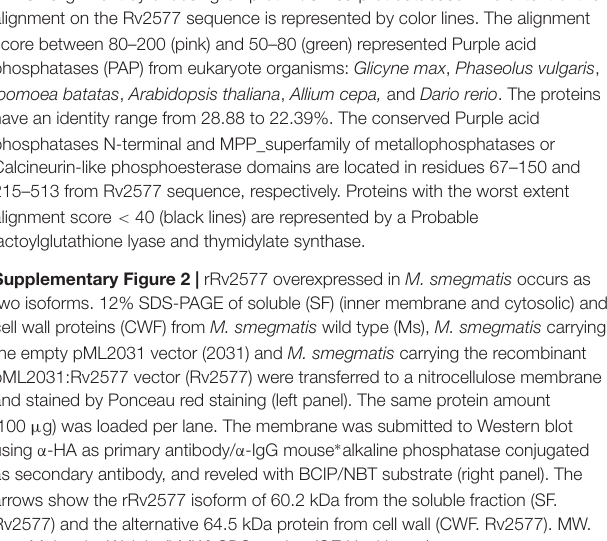
Supplementary Table 1 | Nano-HPLC-MS.MS analysis of Rv2577. Proteins identified in soluble (line 3 to 126) and cell wall fraction (line 129 to 691) from M. smegmatis expressing Rv2577. Proteins identified in supernatants from M.smegmatis expressing